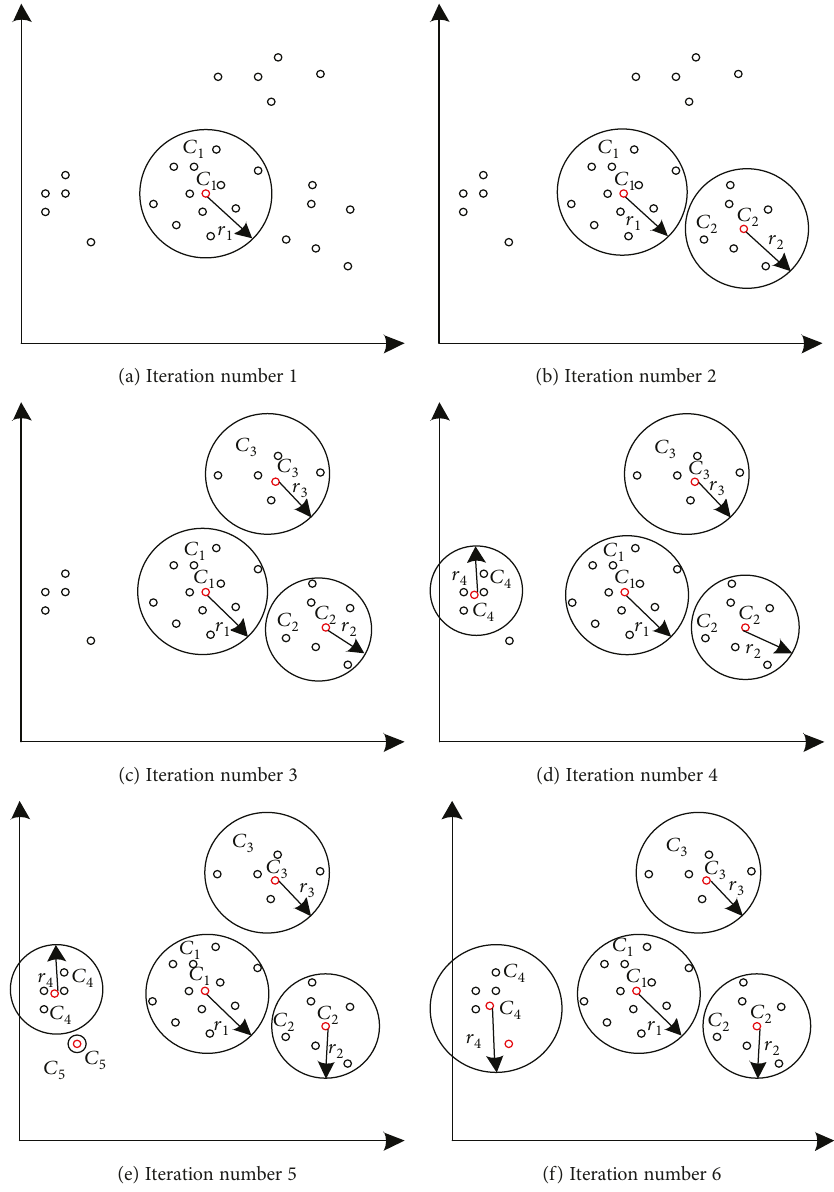
Figure 2: An example of